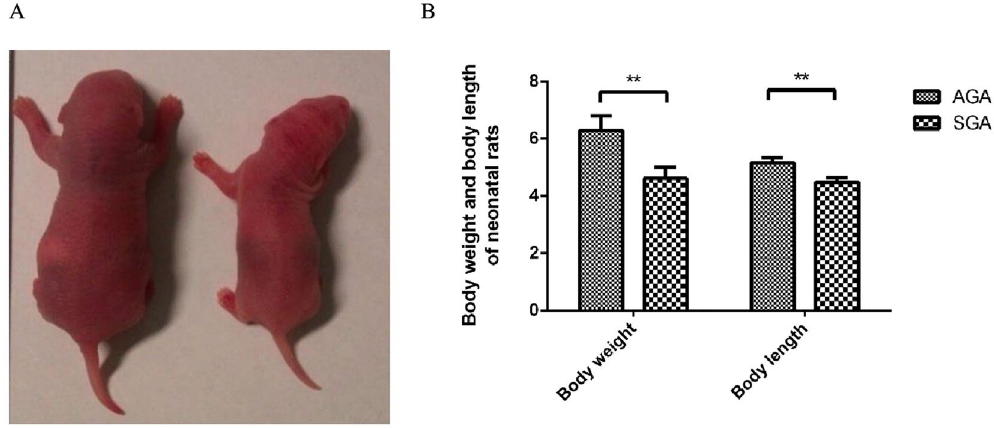
Figure 1. The characteristics of newborn rat pups. The photograph ( A ) and body weight and body length ( B ) of newborn rat pups. Statistical differences between the groups are given as follows: ** p < 0.01: AGA vs SGA. n = 16 per experimental group.